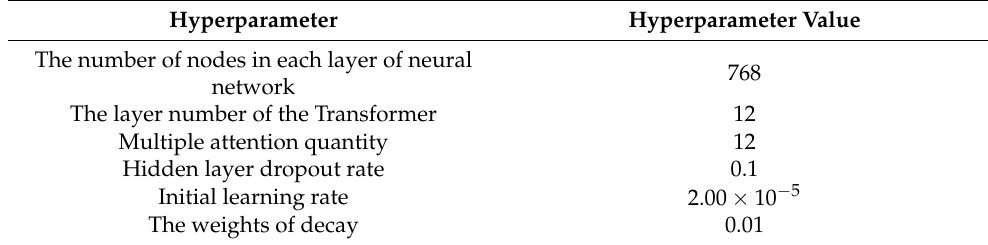
Table 8. Model hyperparameter setting.